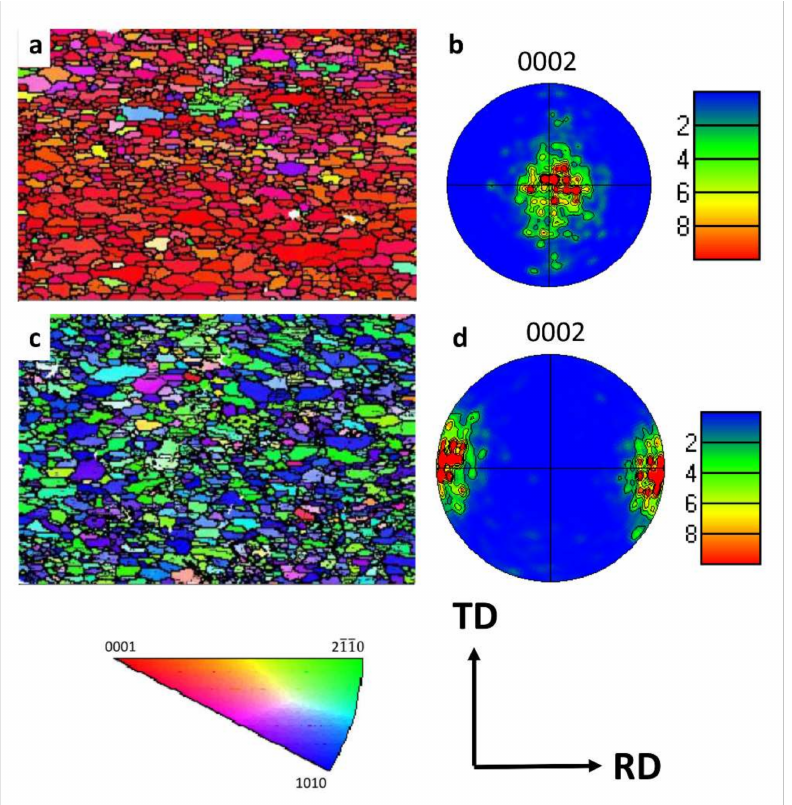
Figure 14. Inverse pole figure and pole figure: ( a ) Inverse pole figure of as-received sheet; ( b ) Pole figure of as-received sheet; ( c ) Inverse pole figure of the deformed sheet; ( d ) Pole figure of the deformed